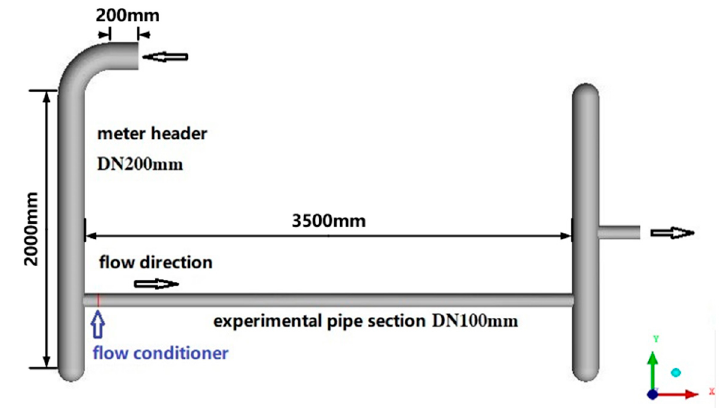
Figure 10. Schematic diagram of computational fluid dynamics (CFD) model.